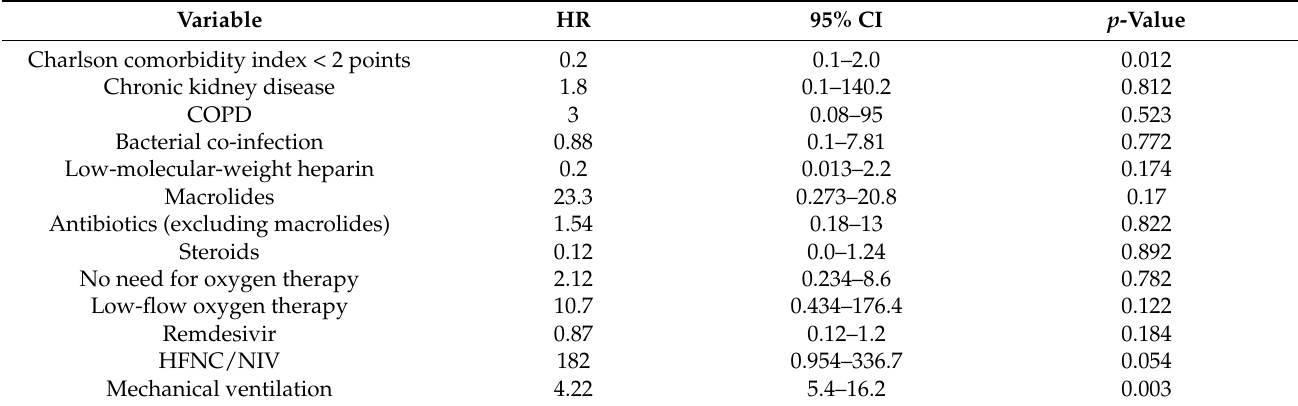
Table 4. Multivariate Cox regression analysis of 30-day mortality after propensity score matching.